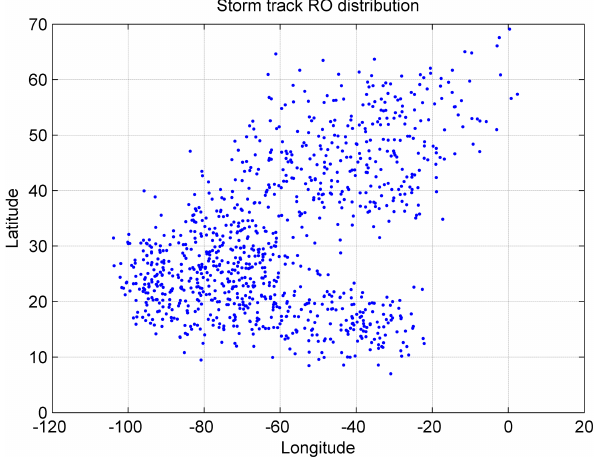
Figure 4. Exemplary distribution of GPS RO profiles in a time win- dow of 6h and spatial window of 600km along 135 tropical storm tracks in the North Atlantic Ocean basin.